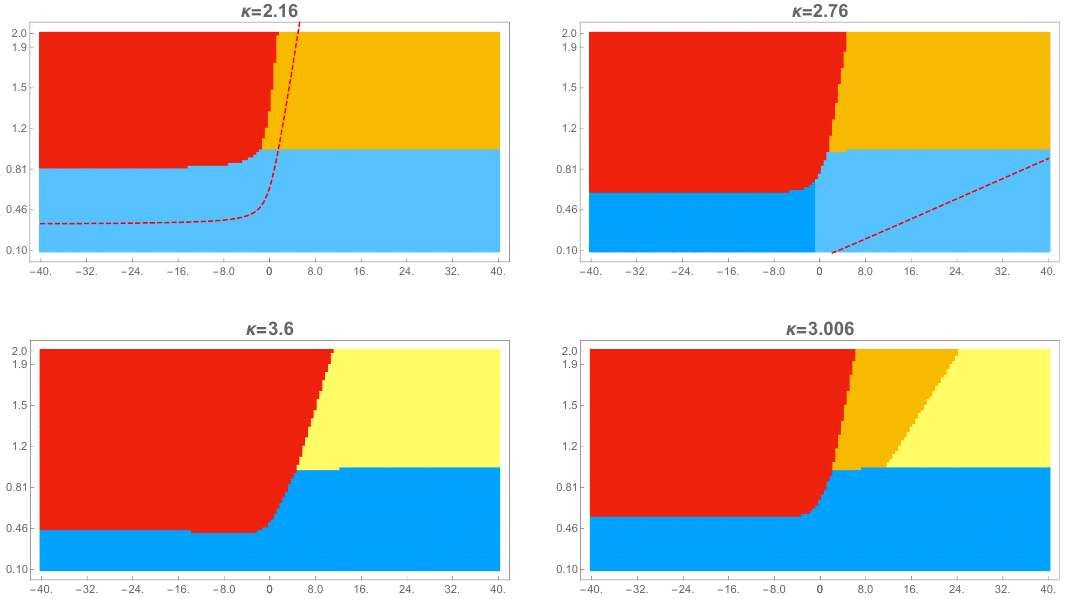
Figure 13 . Phase diagrams for b = 3 , and values of the tension that increase from the top-left figure clockwise. The horizontal and vertical axes are α := γ − γ − 1 and τ . The broken red curve is the bound τ = τ ∗ (1 + γ ) below which the hot solution does not exist (there is no such bound in the 2 lower panels in which the tension λ > λ ). Note the absence of a warm phase in the left ( γ < 1 ) 0 region of the diagrams. For the heaviest wall all non-hot solutions are